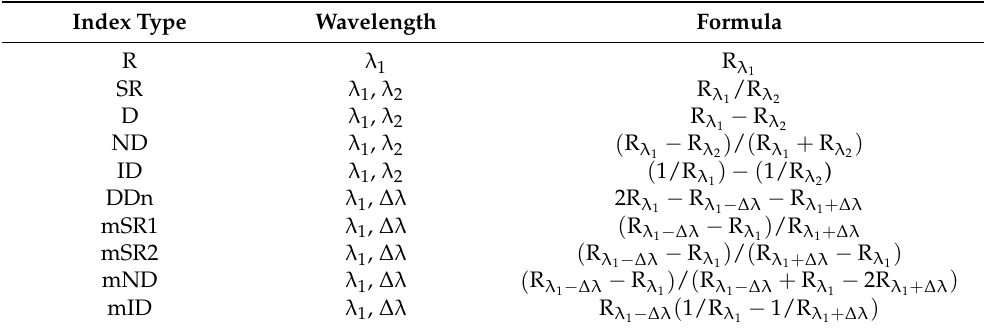
Table 2. New types of indices were developed for the estimation of the chlorophyll (Chl)/carotenoid (Car) ratio in this study. R and the suffixes ( λ 1 or λ 2 ) represent the reflectance and wavelength,